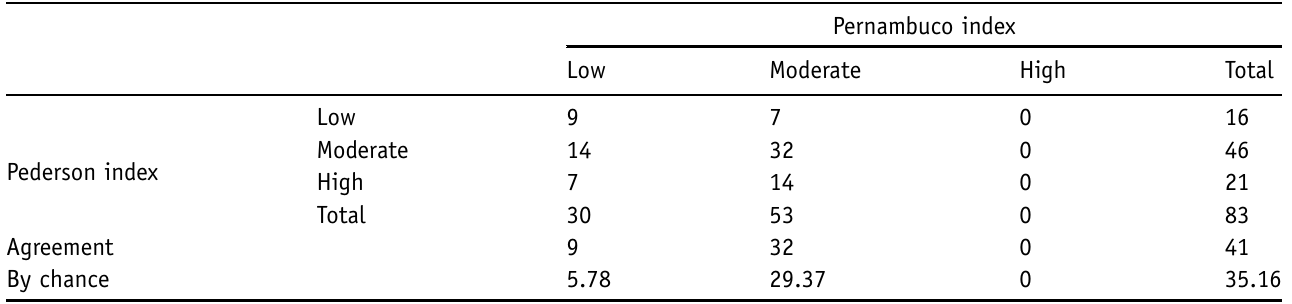
Table V. The agreement between the Pederson and the Pernambuco indexes.